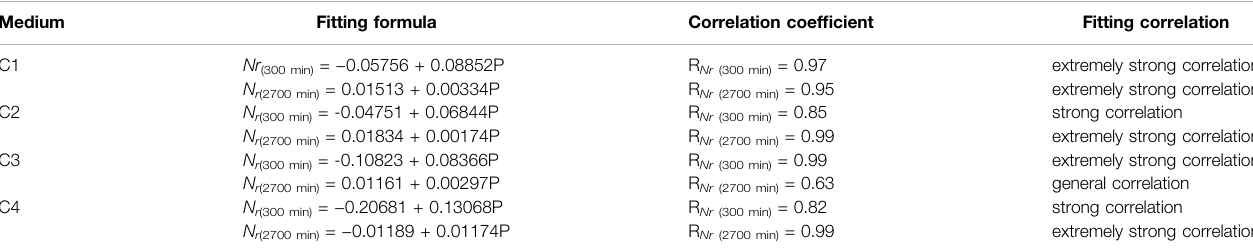
TABLE 3 | Results of fi tting the average growth rate of CO 2 hydrate versus driving force in the C1-C4